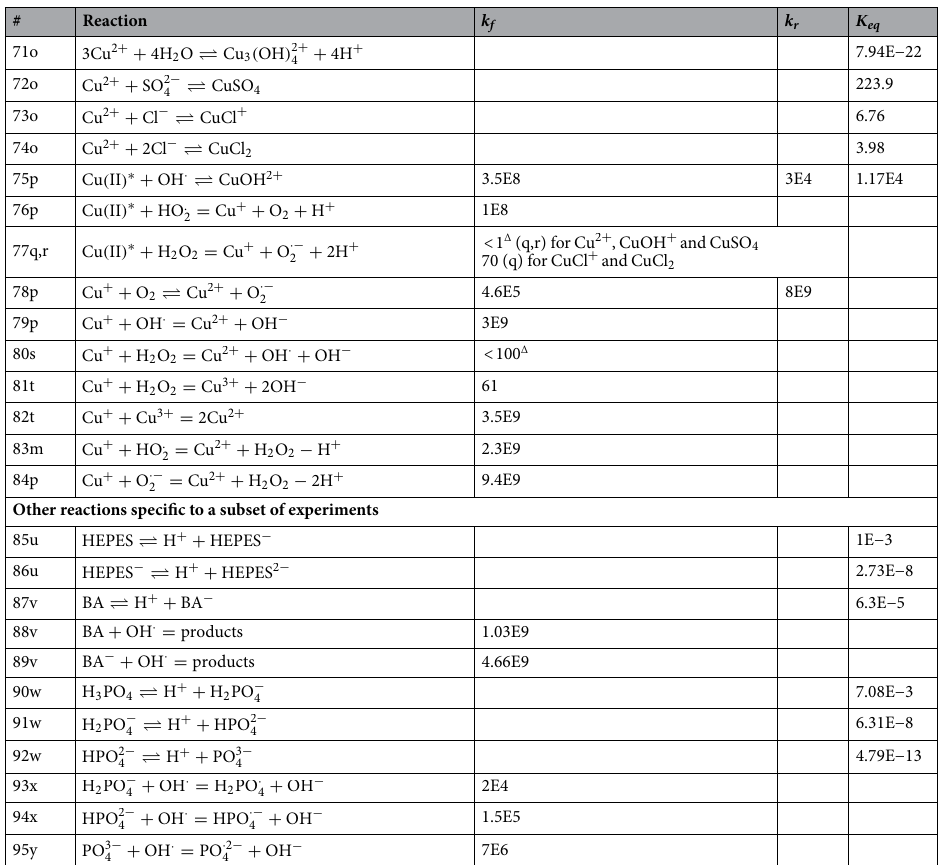
2 + 3 + Table 2. Ascorbic Acid Model (continued). Fe(II)* represents Fe and FeOH + , Fe(III)* represents Fe , FeOH 2 + , Fe ( OH ) + FeCl 2 + . Cu ( II ) ∗ represents Cu 2 + , CuOH + , CuSO 4 , CuCl + and CuCl 2 and 2 . These forward and back reactions are written separately in the KPP input file. ∆ An upper limit is used for these reactions. i Gonzalez et al. 40 , j Miller et al. 58 , k Pham and Waite 51 , l De Laat and Le 38 , m Herrmann et al. 43 , n Stumm and Morgan 50 , o Powell et al. 42 , p Deguillaume et al. 41 , q Wang et al. 59 , r Lee et al. 60 , s Pham et al. 61 , t Pham et al. 62 , u